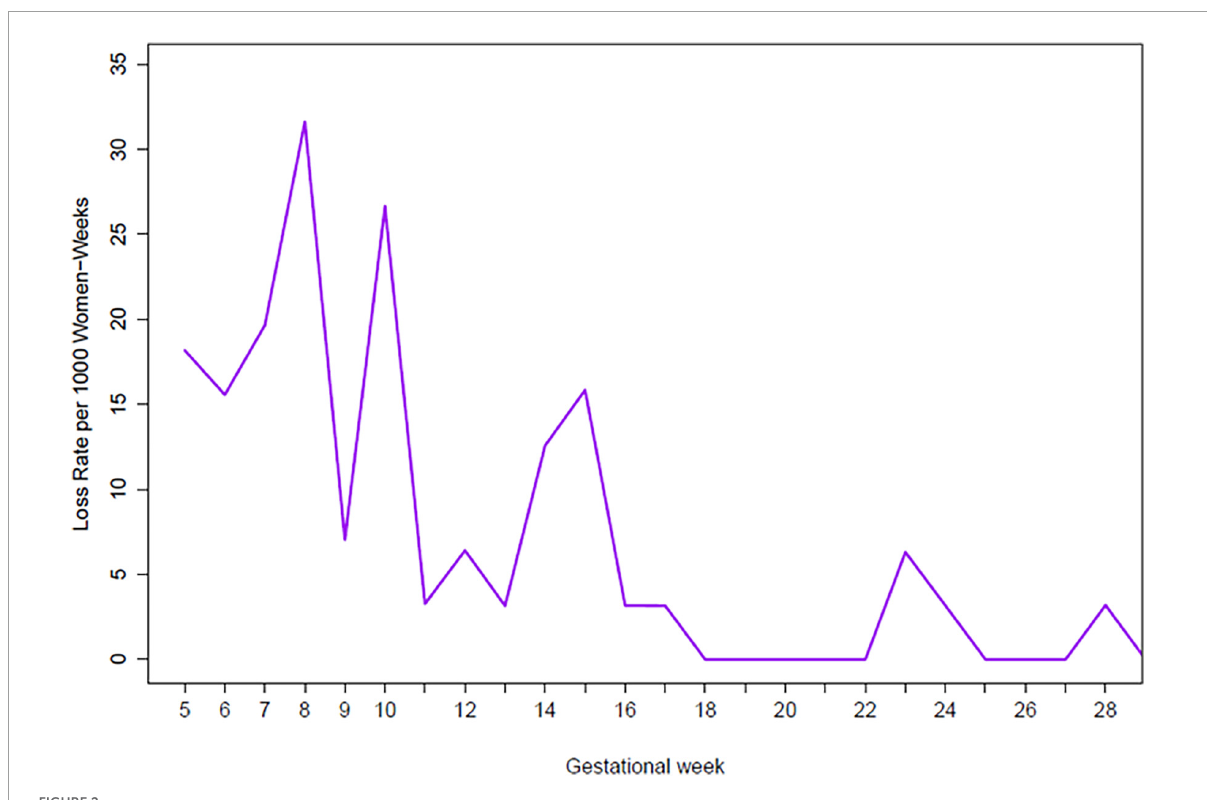
FIGURE2 Miscarriage rate by gestational